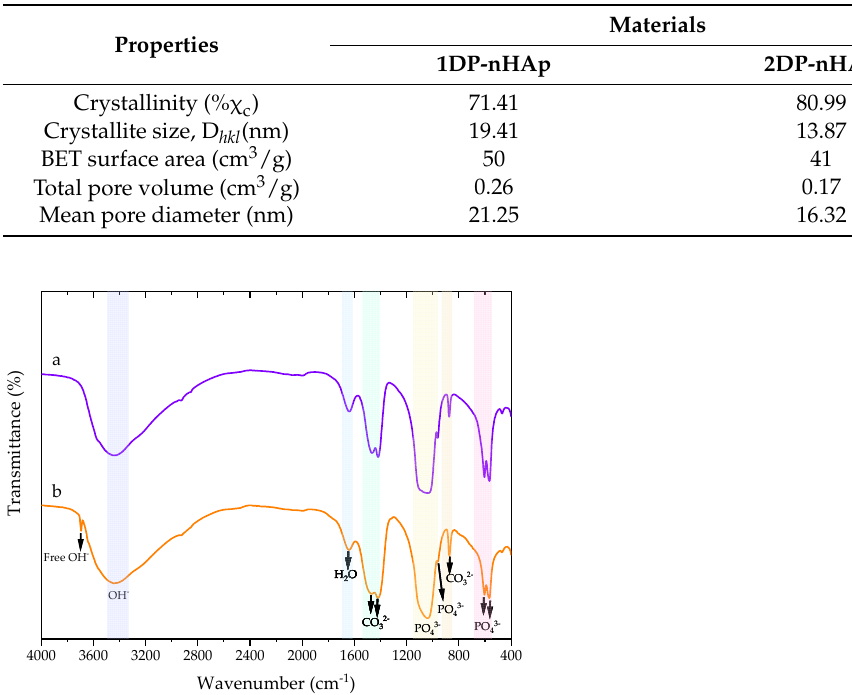
Figure 2. XRD patterns of nHAp powder (a) 1DP-nHAp and (b) 2DP-nHAp. Table 1. The analysis information of n-HAp powder.